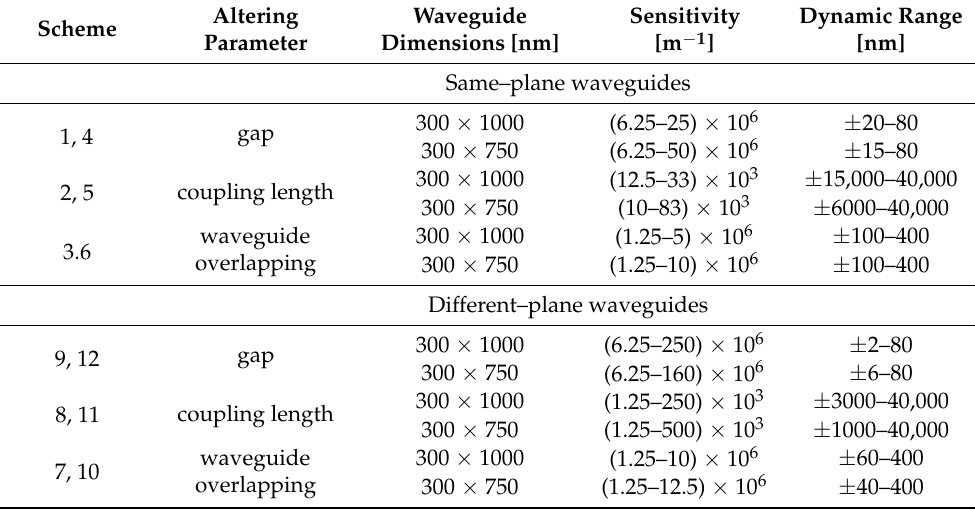
Table 2. Summarized data for the functional schemes of the